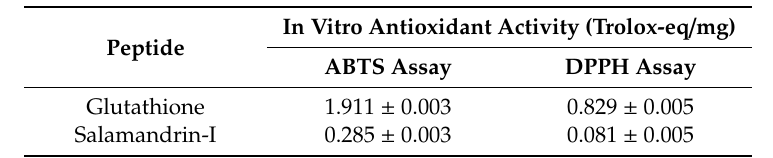
Table 2. Antioxidant capacities of salamandrin-I peptide compared with reduced glutathione according to di ff erent in vitro antioxidant assays. Results are expressed as mg of Trolox equivalent per mg of